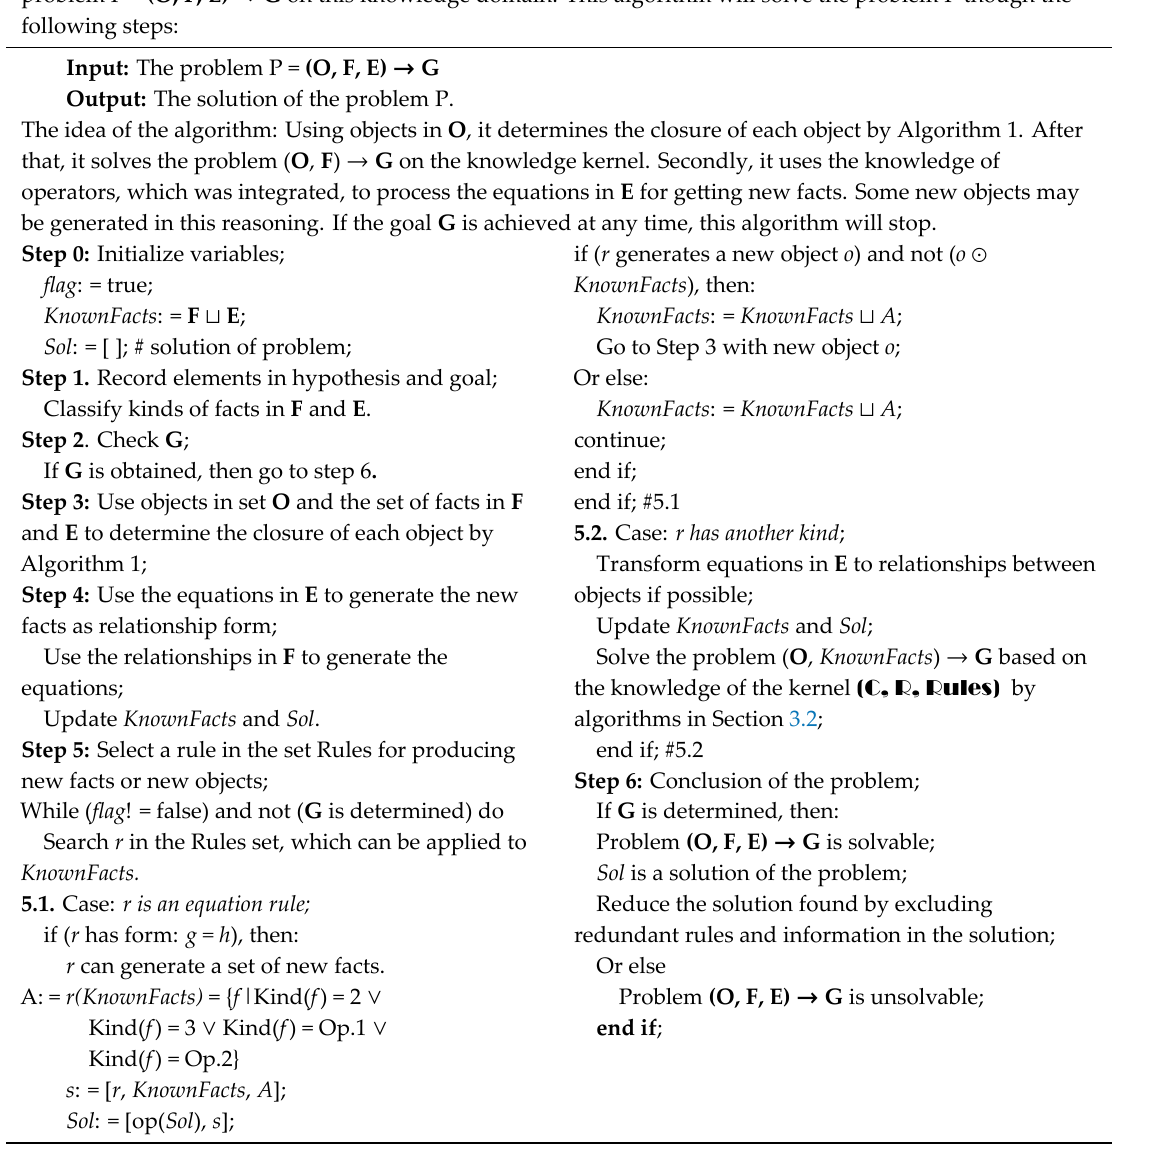
Algorithm 2. Given a knowledge domain combining with operators K = (C, R, Rules) + Ops , and